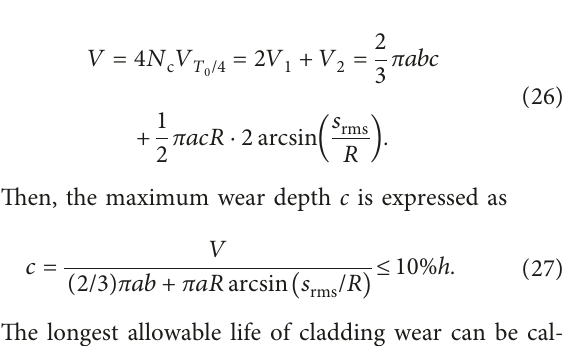
Figure 6: Wear rate as a function of normal